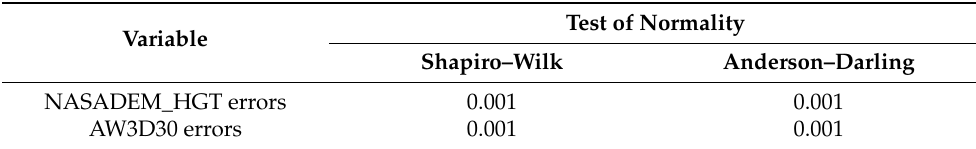
Table 8. Tests of normality of the altitude discrepancies.